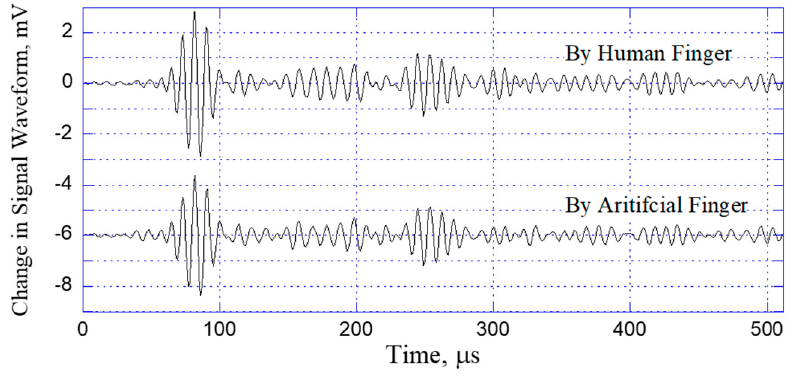
Figure 7. Comparison of changes induced in received acoustic waveforms by human finger and gelatin artificial finger.